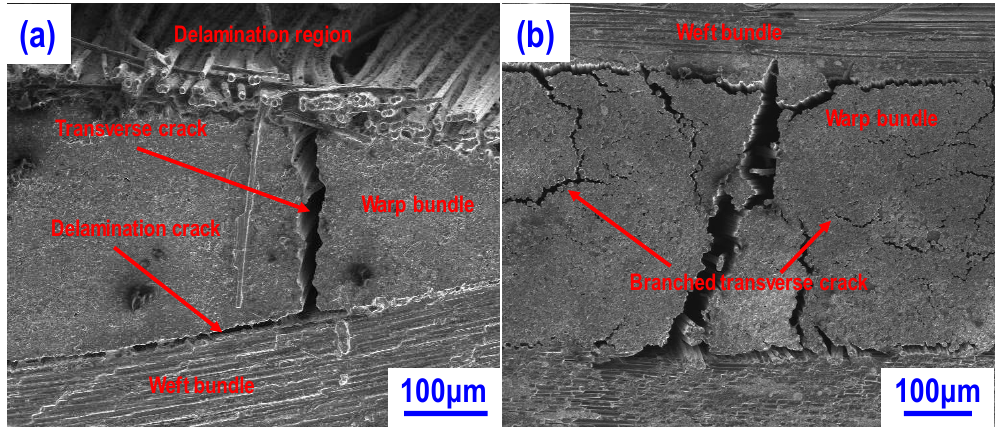
Figure 1. Surface morphologies of C / C preforms: ( a ) C / C preform without ZrC nanoparticles; ( b ) C / C preform with ZrC nanoparticles.